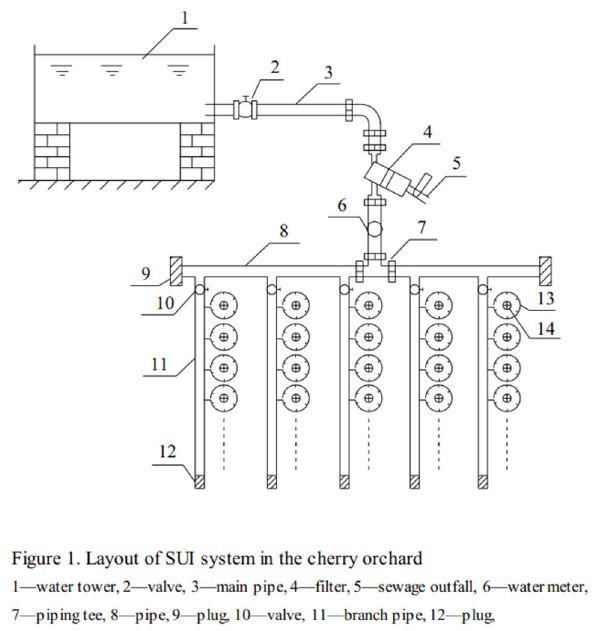
Figure 1. Layout of SUI system in the cherry